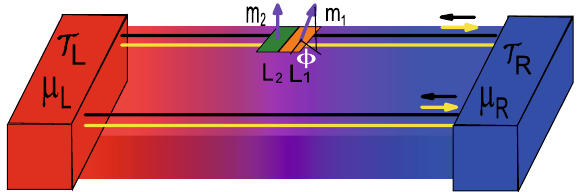
Figure 1. Schematic diagram of a QSHI system connected to a hot and a cold lead. Two nanomagnets with magnetic moments m 1 and m 2 and lengths L 1 and L 2 are contacted to a helical Kramers pair of edge states. A thermal gradient (cid:31) T T T R =